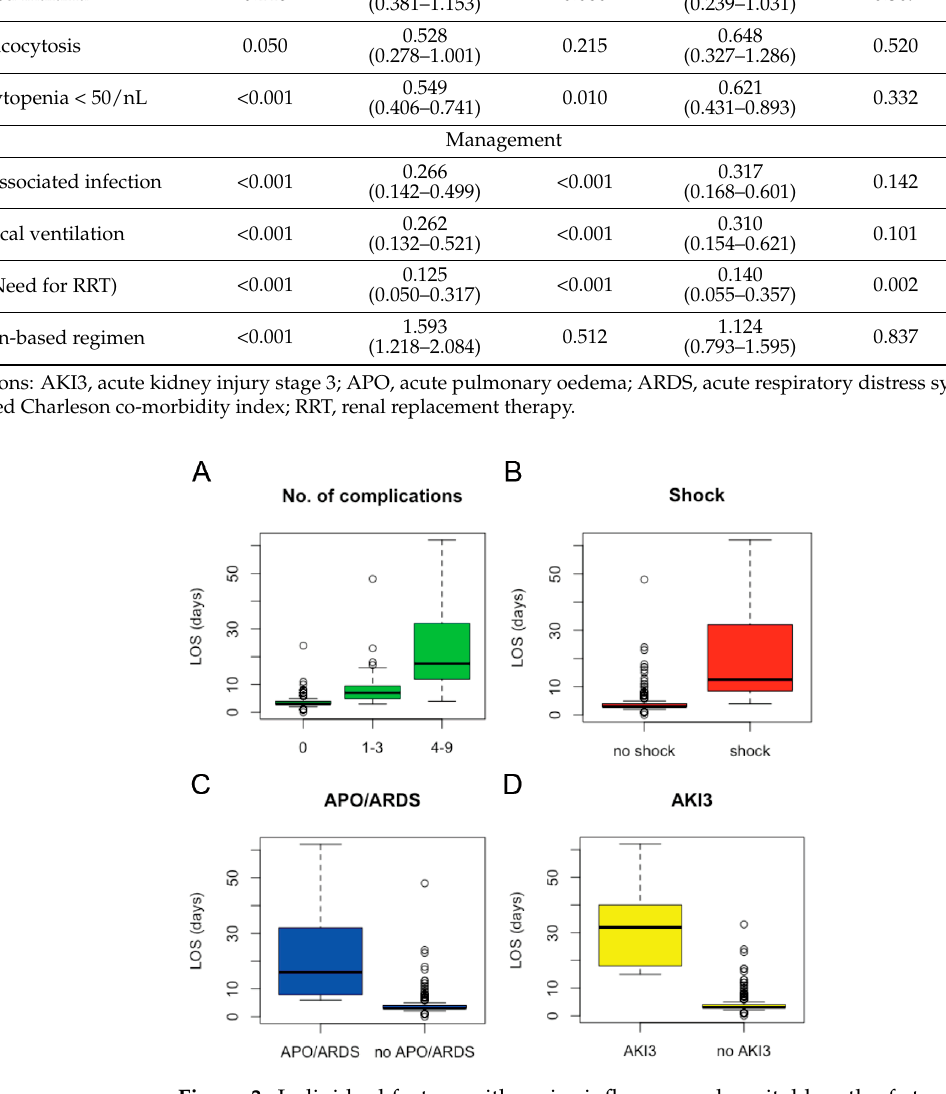
Figure 3. Individual factors with major influence on hospital length of stay among the 535 cases with imported falciparum malaria were the number of presenting syndromes ( A ), shock ( B ), APO or ARDS ( C ), and acute renal failure requiring renal replacement therapy (AKI3) ( D ). Table 4. Factors associated with hospital length of stay in multivariate